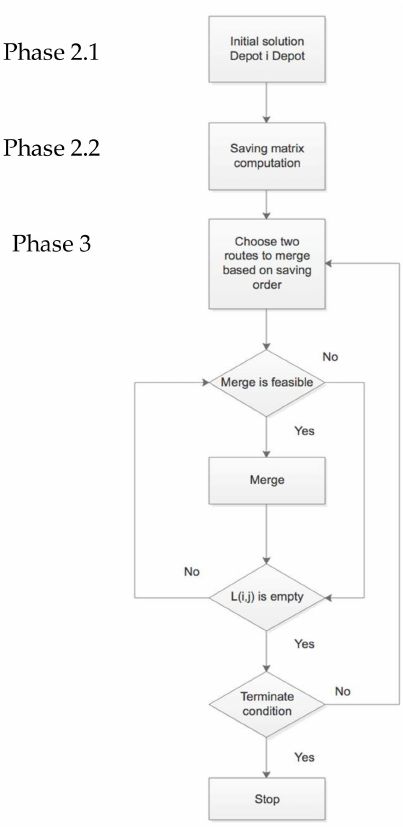
Figure 2. Flowchart of Saving